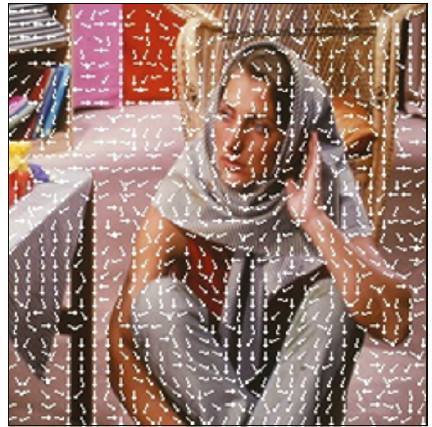
Figure 3: Tensor directions of Barbara